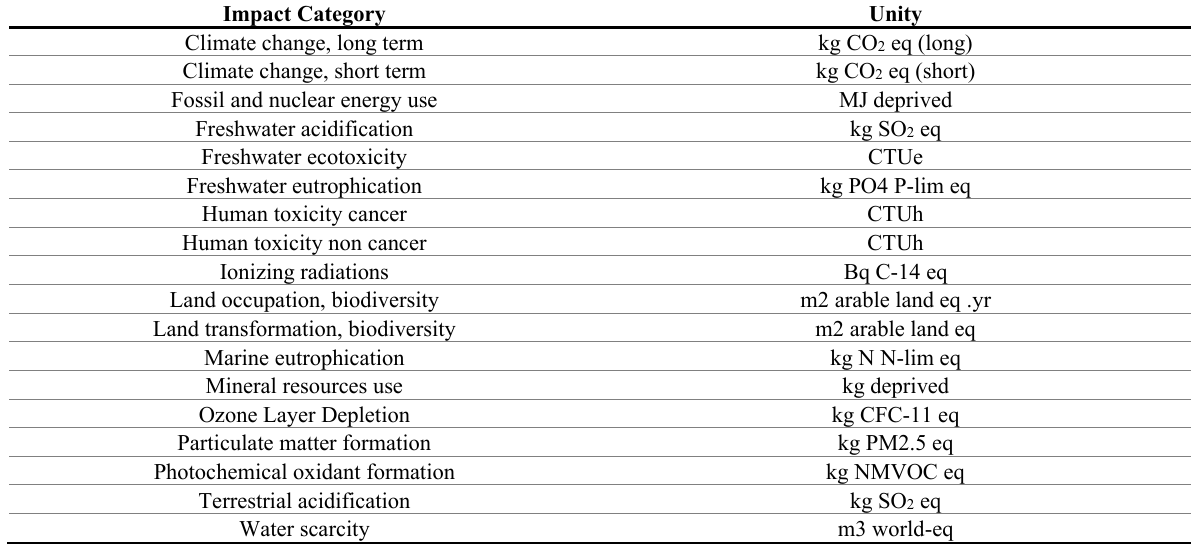
Table 5. Impact categories of the Impact World+ LCIA